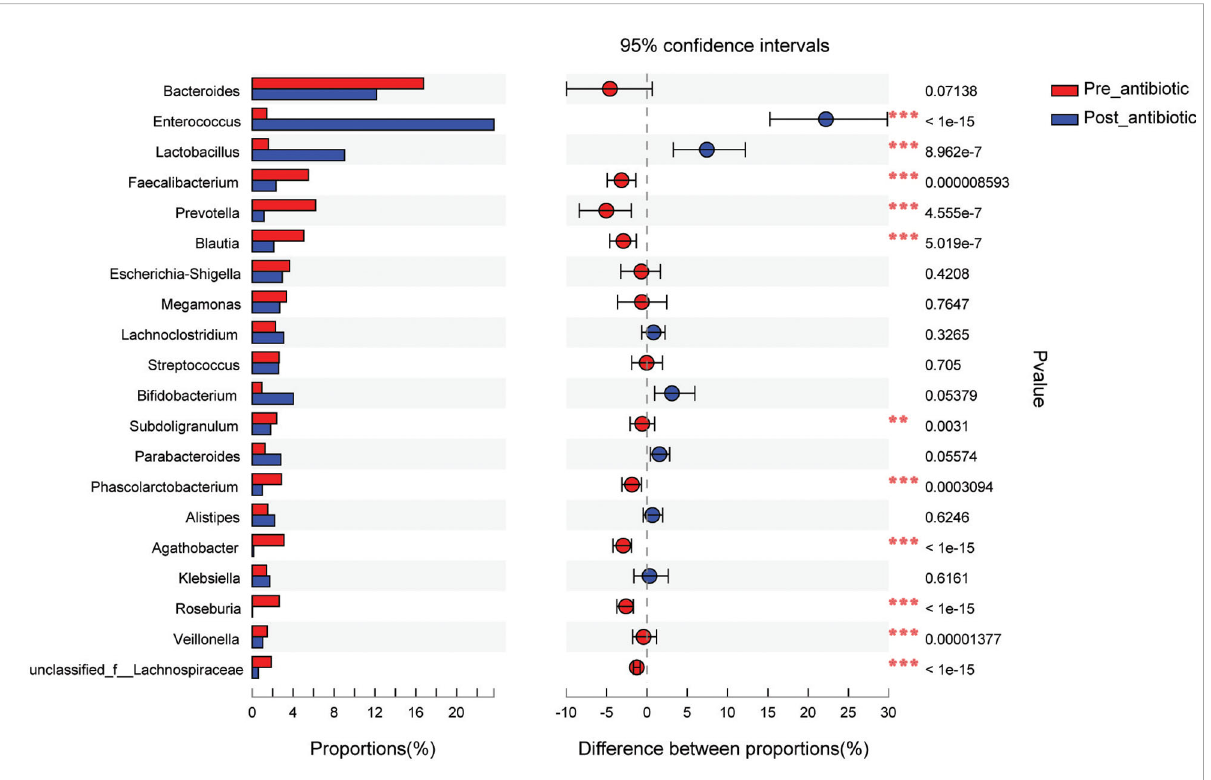
TABLE 3 Change of the relative abundance of gut bacteria involved enzyme post sulperazone treatment in the process of menaquinone biosynthesis. Enzyme Description